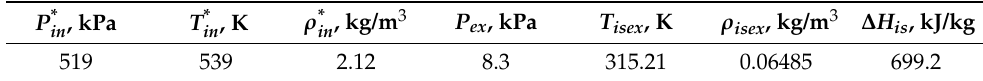
Table 1. Inlet/outlet boundary conditions and isentropic quantities.